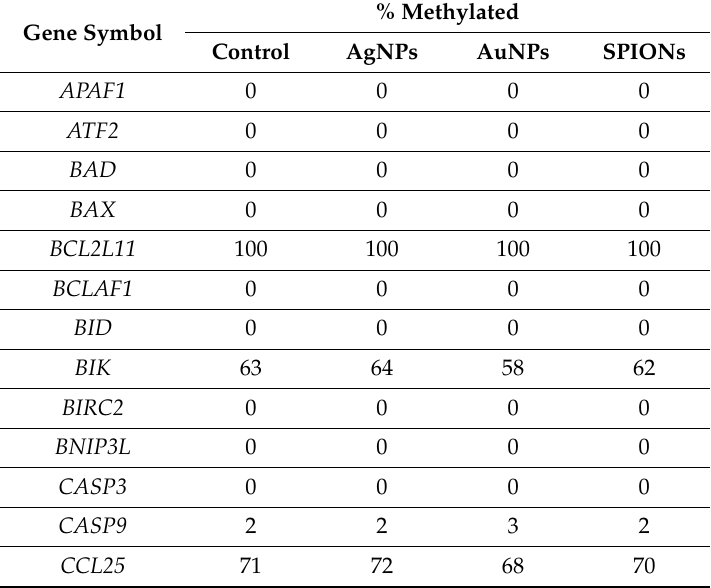
Table 1. Methylation analysis of the promoter region of selected genes related to inflammatory response and apoptosis. HepG2 cells were treated with AgNPs (10 µ g/mL), AuNPs (10 µ g/mL) and SPIONs (5 µ g/mL) for 24 h. Data are presented as the mean from three independent experiments. Differences were not statistically